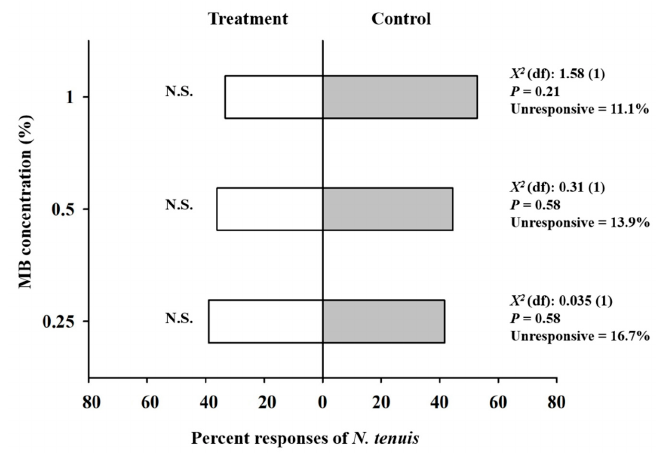
Figure 2. Percent olfactory responses of adults of Nesidiocoris tenuis to methyl benzoate (MB) concentrations in a Y-tube olfactometer assay. A response was defined as traversing more than one third of the length of either odor-source branch. N.S. indicates no significant di ff erence between the olfactory responses to an MB concentration and the control (distilled water